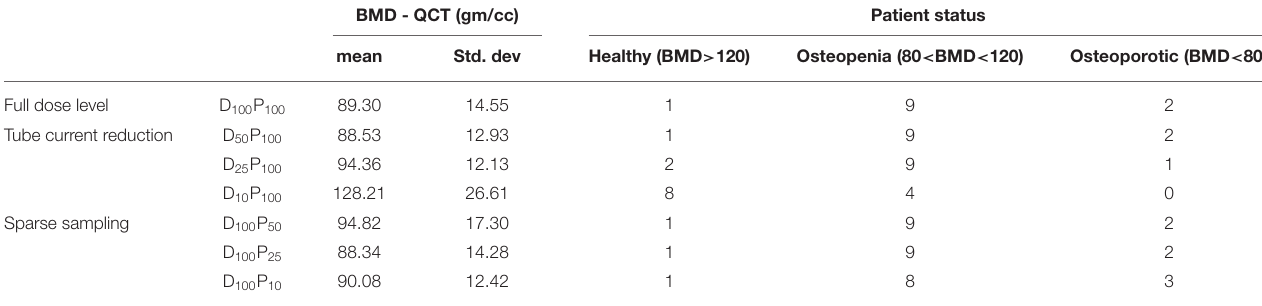
TABLE 3 | Bone mineral density (BMD) measurements for vertebrae at different dose